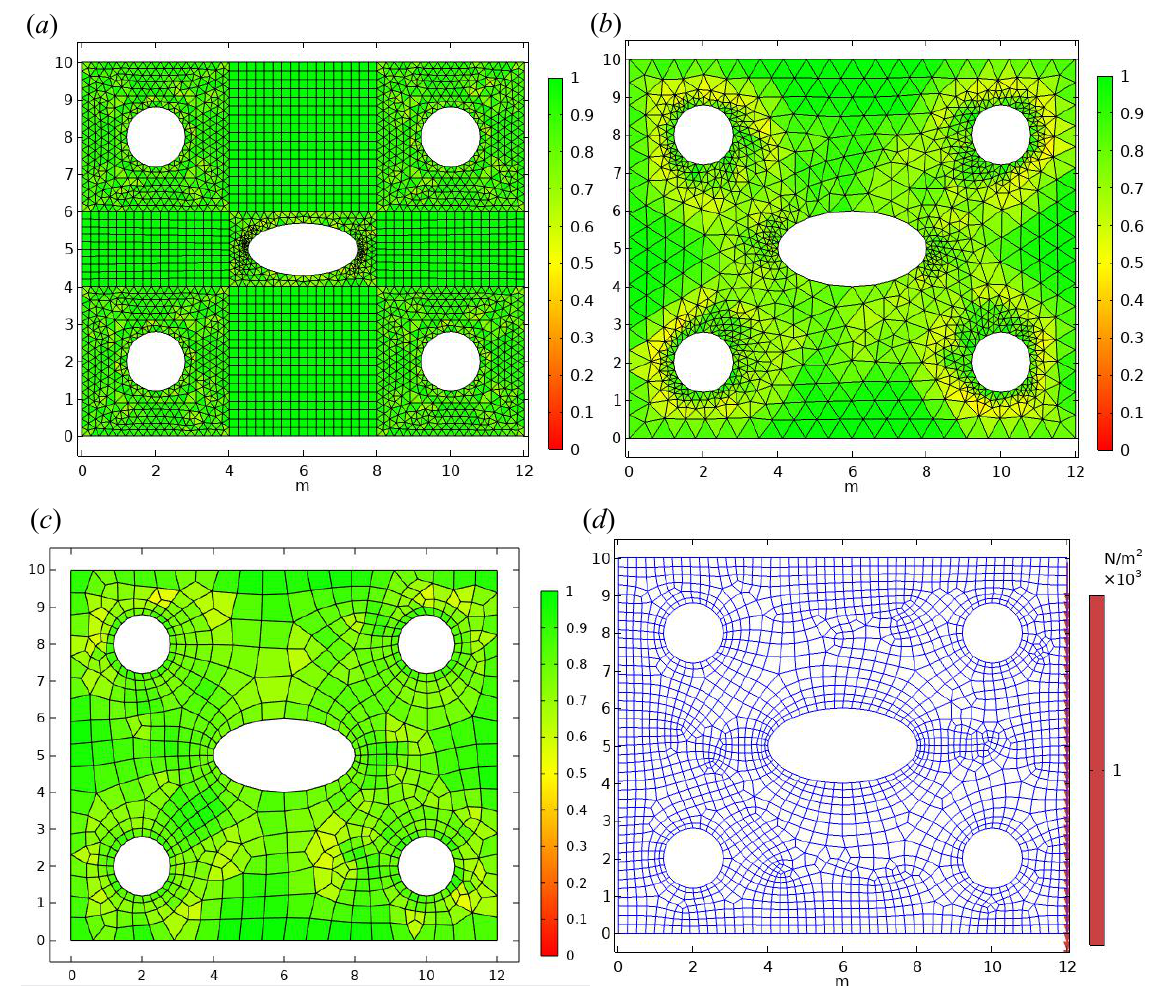
Figure 2. Comparison of hybrid finite-element mesh and adaptive mesh. ( a ) Hybrid finite-element mesh quality assessment chart. ( b ) CST adaptive mesh quality assessment renderings. ( c ) Q4 adaptive (b) Q4 自适应网格单元质量评估图 mesh element quality assessment diagram. ( d ) Schematic diagram of the refined Q4 adaptive mesh and boundary